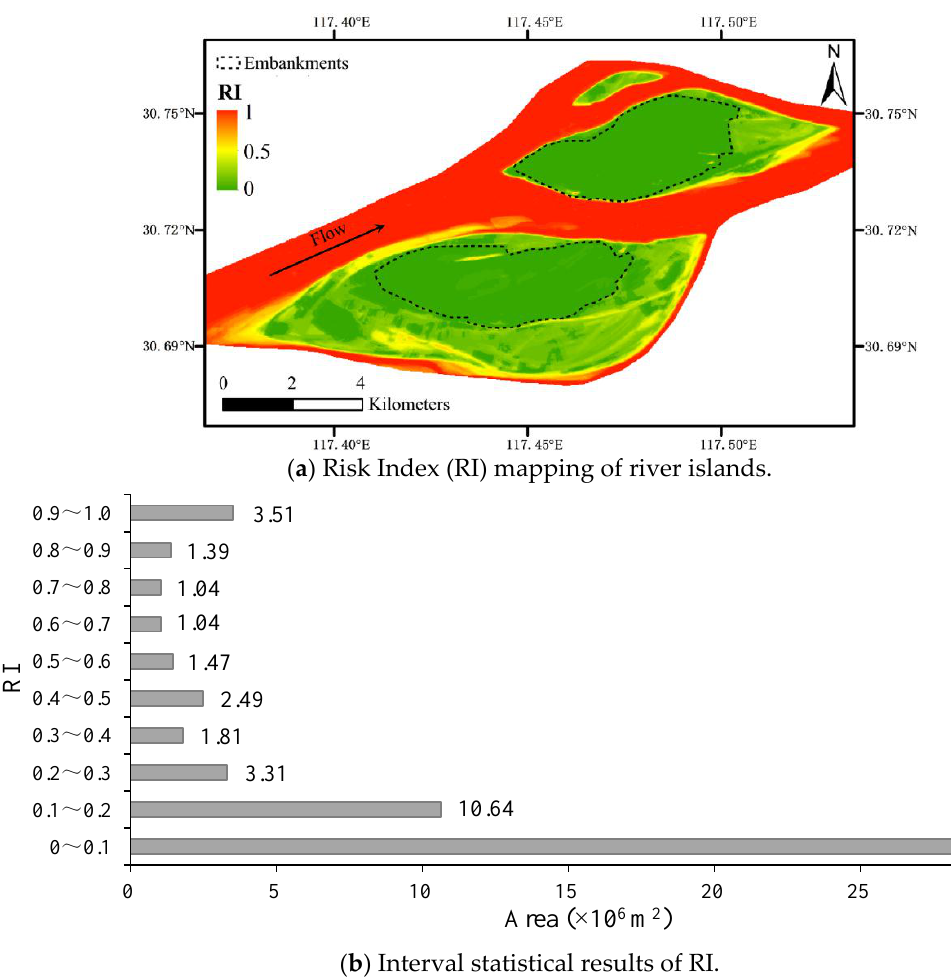
( b ) Interval statistical results of RI. Figure 10. The river island Inundation Risk Index. Figure 10. The river island Inundation Risk